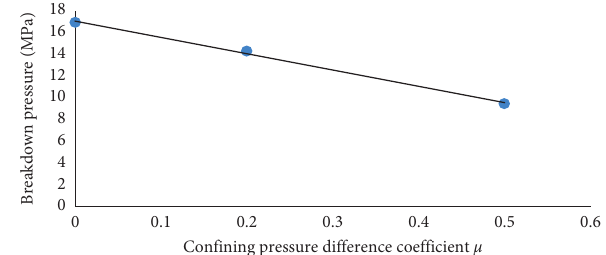
Figure 9: Breakdown pressure of varying confining pressure difference coefficient